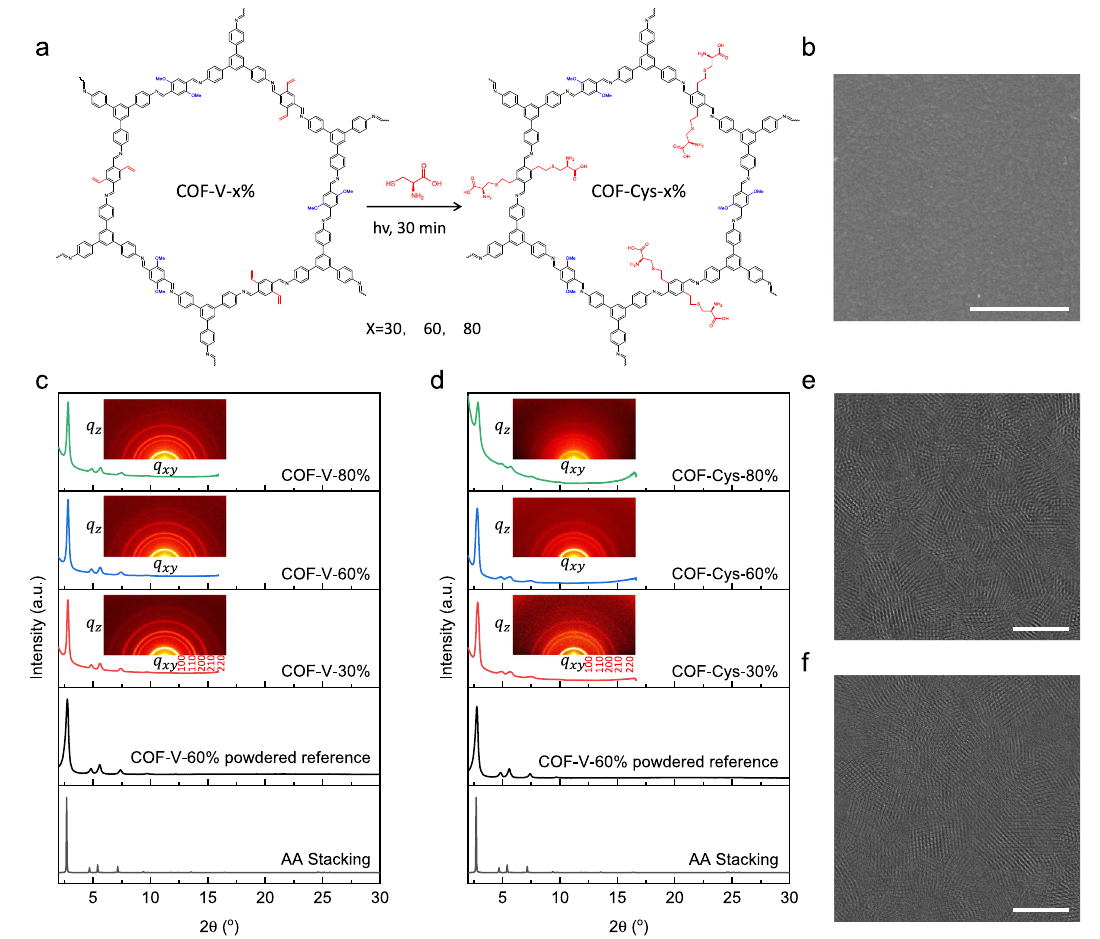
Fig. 2 | Preparation and characterization of COF-Cys membranes. a Interfacial polymerization of COF-V-x membranes and rapid synthesis of COF-Cys-x mem- branes via a thiol-ene click reaction. b SEM image of COF-Cys-60% membrane showing defect-free surface morphology (scale bar, 500nm). Projection of the in- plane diffraction patterns from the grazing incidence wide-angle X-ray scattering